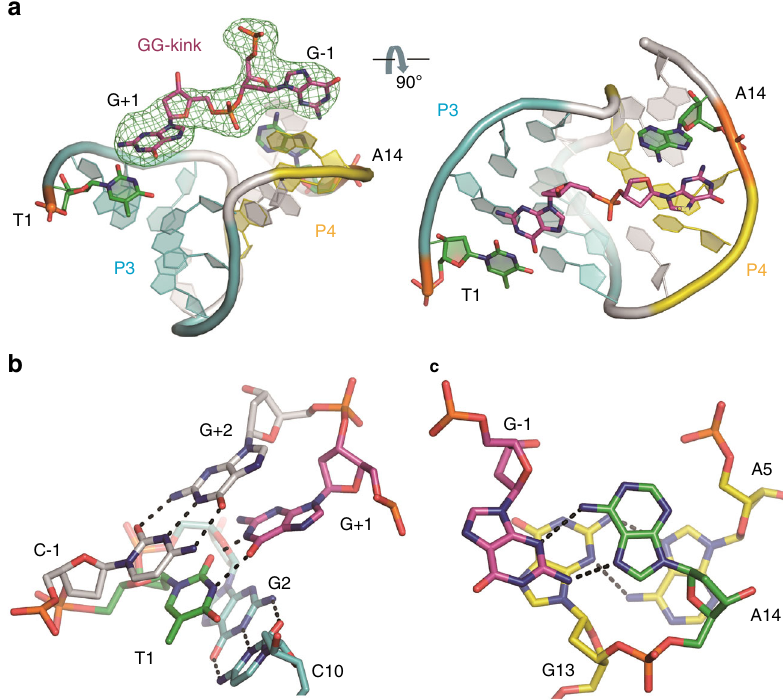
Fig. 2 Interactions between the catalytic core and the GG-kink. a The relative arrangement between the catalytic core and the GG-kink, based on the DNAzyme-Pb 2+ complex structure. The annealed F o -F c omit map for the GG-kink is contoured at 3.0 σ level and colored in green. b T:G Wobble pair between T1 and G + 1. ( c ) The non-canonical A:G pairing between A14 and G-1. In b , c , the residues are shown as stick models in the same color scheme for N (blue), O (red), and P (orange) atoms, but the C-atoms are colored in magenta, green, cyan, white, and yellow for G − 1 and G+1, T1, and A14, the G2:C10 pair, the last pair of P1, and the A5:G13 pair,